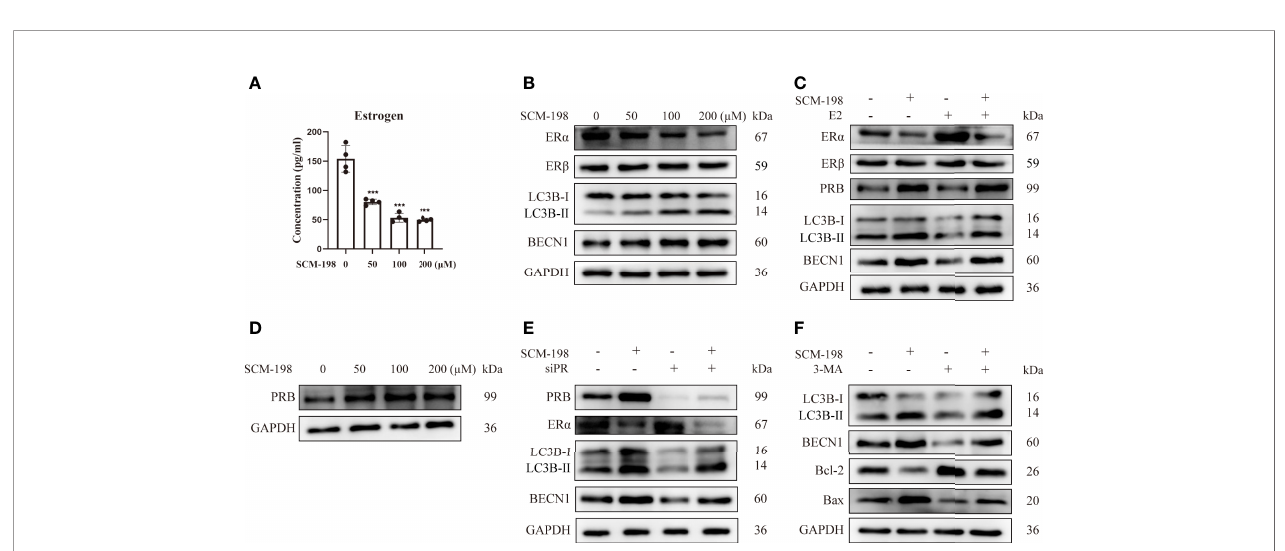
FIGURE 4 | SCM-198 promotes the autophagy-mediated apoptosis of eESCs by inhibiting the estrogen-ER a pathway and promoting PR expression. (A) After treatment with different concentrations of SCM-198 for 48 h, the estrogen concentration of eESCs was analyzed via ELISA (n = 4). (B) The eESCs were treated with different concentrations of SCM-198 for 48 h, and then protein expressions of ER a , ER b , LC3B-II/I, and BECN1 were analyzed via Western blotting. (C) The protein expressions of ER a , ER b , PRB, LC3B-II/I, and BECN1 were detected via Western blotting in eESCs treated with SCM-198 (200 µM), E2 (100 nM), or SCM-198+E2 (200 µM, 100 nM) for 48 h. (D) The eESCs were treated with different concentrations of SCM-198 for 48 h, after which the protein expression of PRB was analyzed via Western blotting. (E) After treatment with SCM-198 (200 µM), silenced PR, or SCM-198+silenced PR for 48 h, the protein expressions of PRB, ER a , LC3B-II/I, and BECN1 in eESCs were detected via Western blotting. (F) After treatment with SCM-198 (200 µM), 3-MA (5 mM), or SCM-198+3-MA (200 µM, 5 mM) for 48 h, the expressions of LC3B-II/I, BECN1, Bcl-2, and Bax in eESCs were analyzed via Western blotting. Continuous data are presented as the mean ± SD (*** P < 0.001; compared with eESCs that were not treated with